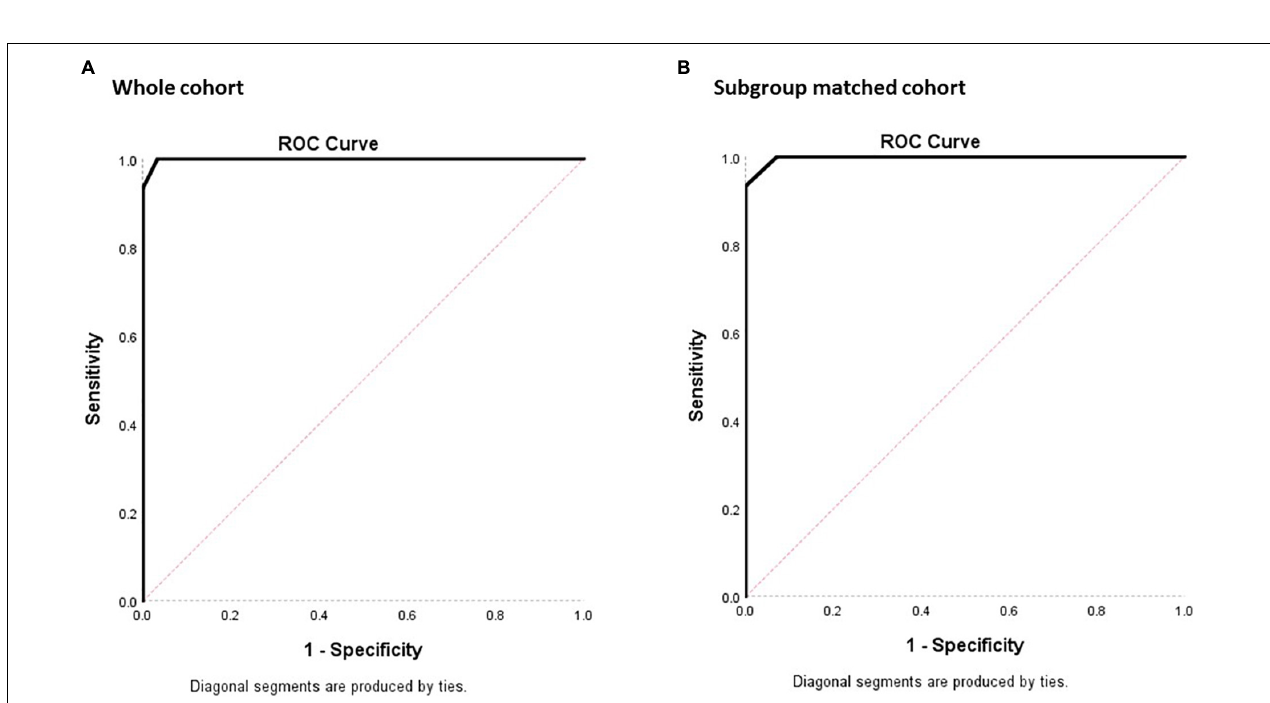
FIGURE 4 | ROC plots of sensitivity against 1- specificity for the MoCA-HA tool of the NC-HI and the D-HI cohort to demonstrate the screening property of the tool. (A) The 30 NC-HI and 15 D-HI cohorts. (B) The matched 14 NC-HI and 15 D-HI cohorts. (The diagonal line demonstrates no significant diagnostic property for the dichotomous outcome with sensitivity = 50% and specificity =